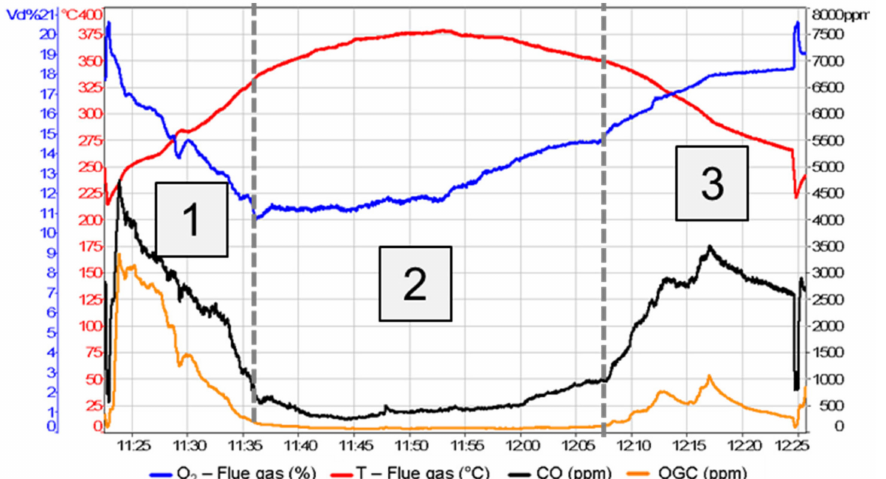
Figure 6. Characteristic phases of batch-wise firewood combustion: (1) start-up phase, (2) main burning phase, (3) burn-out phase [47]. Reprint with permission from G. Reichert, Primary- and Secondary Measures for Manually Fired Stoves - An Overview. 6th Central European Biomass Conference, 2020, Austria, Graz; Copyright 2020, BEST GmbH.